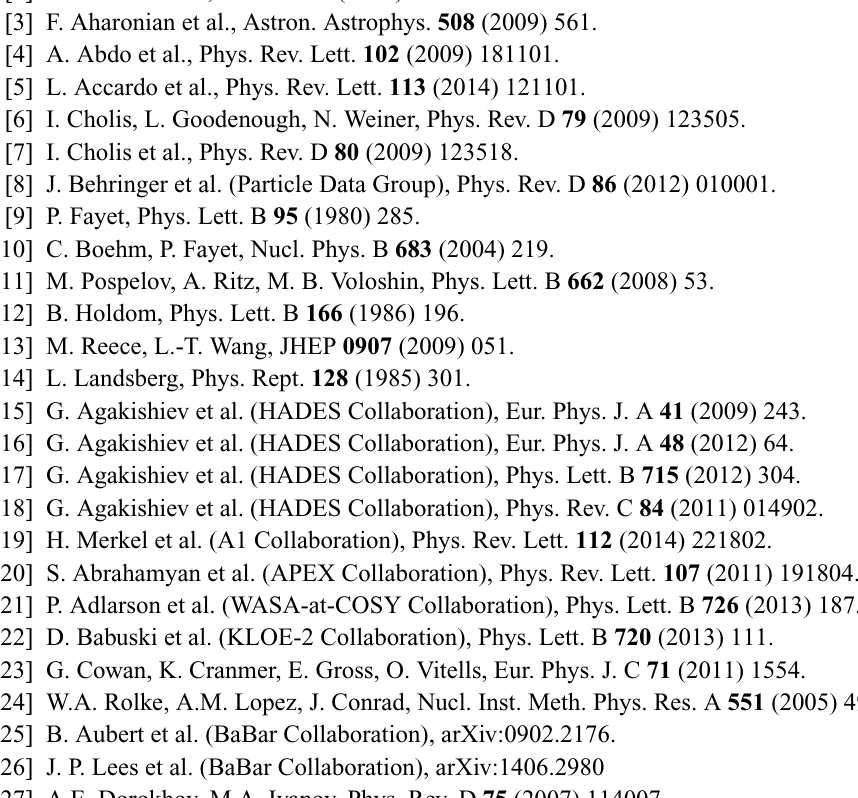
Figure 2. (Color online) Zoom into the η peak region of the invariant-mass distribution of e + e − pairs reconstructed in the p(3.5 GeV) + Nb reaction. The data is fitted with a polynomial (dashed black curve) onto which is a gaussian signal of strength S set equal to the found upper limit (CL = 90%) of BR η → e + e − < 2 . 5 × 10 − 6 (solid red and pink